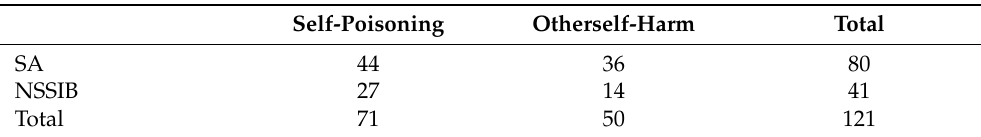
Table 3. Distribution of self-poisoning and other types of self-harm (sharp objects, hanging, strangu- lation, jumping) in the group of patients with suicide attempt (SA) and non-suicidal self-injurious behavior